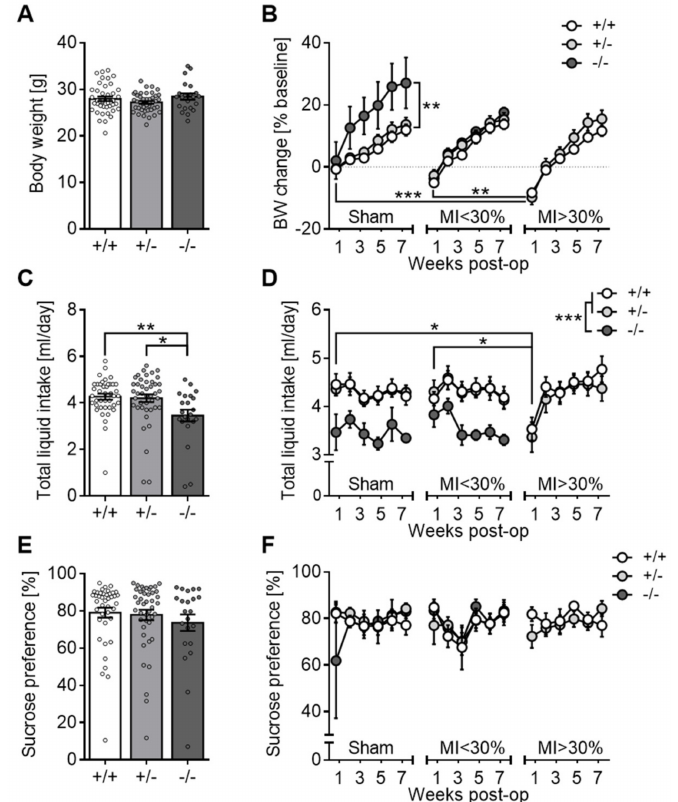
Figure 5. Body weight, liquid intake and sucrose preference before and after surgery. Presurgical body weights were comparable among genotypes ( A ). Postoperatively, sham-operated 5-HTT − / − mice gained more weight than respective controls and mice with large infarcts (MI > 30%) exhibited greater weight loss than sham and MI < 30% mice in the first week post-op ( B ). 5-HTT null mutants drank less than the other two genotypes both before ( C ) and after surgery ( D ), and liquid intake was significantly diminished in MI > 30% mice at week 1 post-op ( D ). Sucrose preference was comparable among genotypes at baseline ( E ) and did not significantly change postoperatively, neither across genotypes nor between sham vs. MI mice ( F ). Data are shown as mean ± SEM. * p < 0.05, ** p < 0.01, *** p < 0.001. ( A , C , E ) one-way ANOVA followed Tukey post hoc test; ( B , D , F ) three-way mixed ANOVA followed by Sidak multiple comparisons